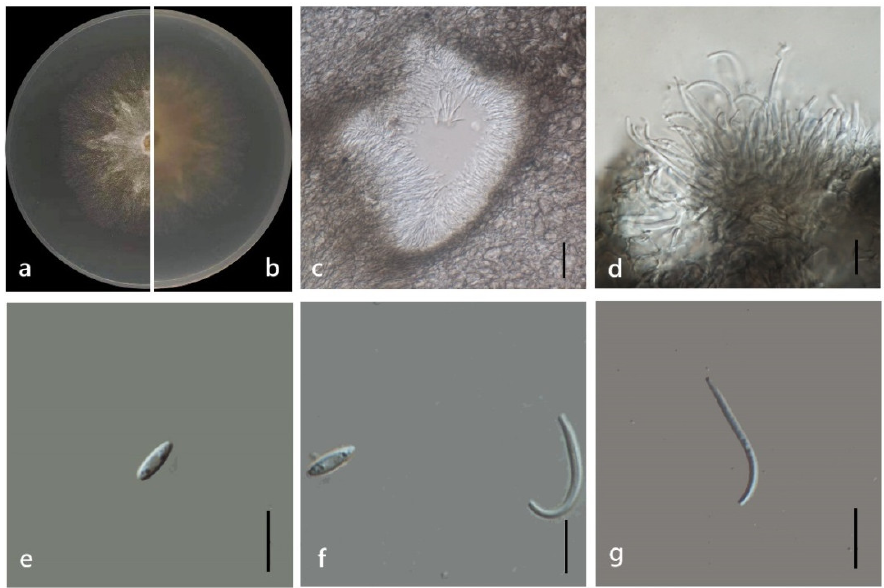
Figure 8. Diaporthe longiconidialis (ZHKUCC 22-0058) ( a ) upper view of colonies on PDA; ( b ) Re- verse view of colonies on PDA; ( c ) Horizontal section through a pycnidia; ( d ) Conidiogenous cells; ( e , f ) Alpha conidia; ( f , g ) Beta conidia. Scale bars: ( c ) =100 µm; ( d – g ) =10